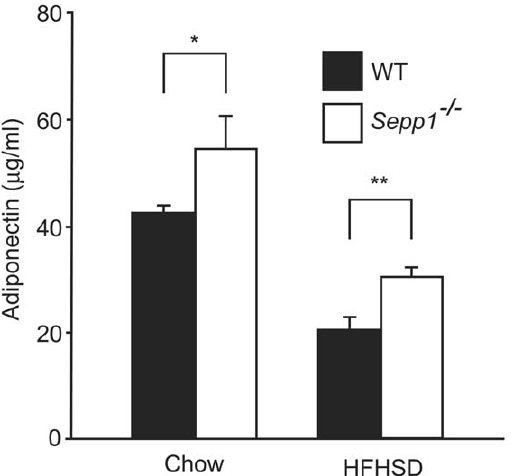
Figure 3. Blood levels of adiponectin in selenoprotein P- knockout and wild-type mice fed regular chow or a high fat, high sucrose diet (n=5–10). Sixteen week old male mice were fed a high fat, high sucrose diet for 16 weeks. Data represents the means 6 SEM. *p , 0.05, **p , 0.01, vs. wild-type mice.